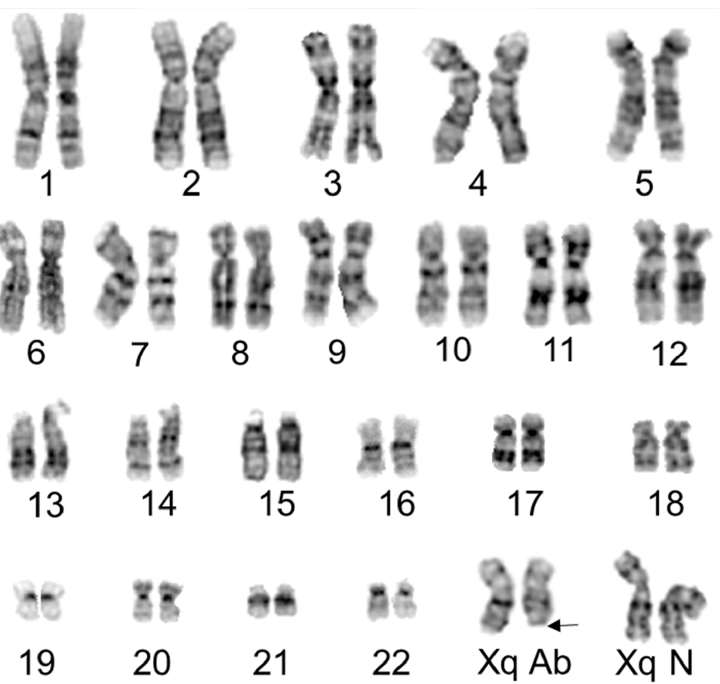
Figure 1. Composite karyogram of HUVEC cells at the 425-band level of resolution. Chromosomes 1–22 showed no consistent variation of banding pattern, while several cells displayed abnormal mor- phology in the terminal region of the long arm of chromosome X (Xq Ab as indicated by arrow) and the rest of the cells exhibit normal Xq region (Xq N). Images were captured under 100 ×